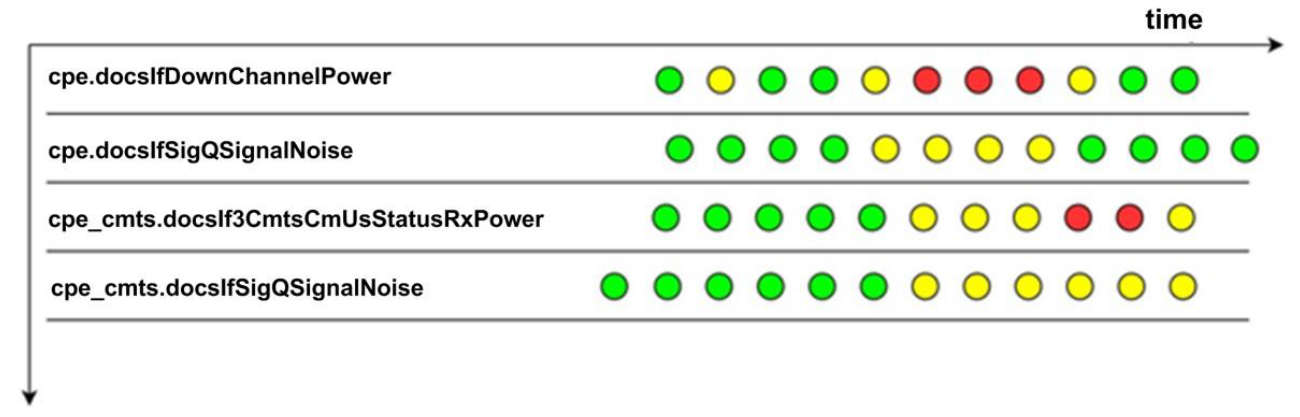
Table 5. Thresholds for combined grade G i